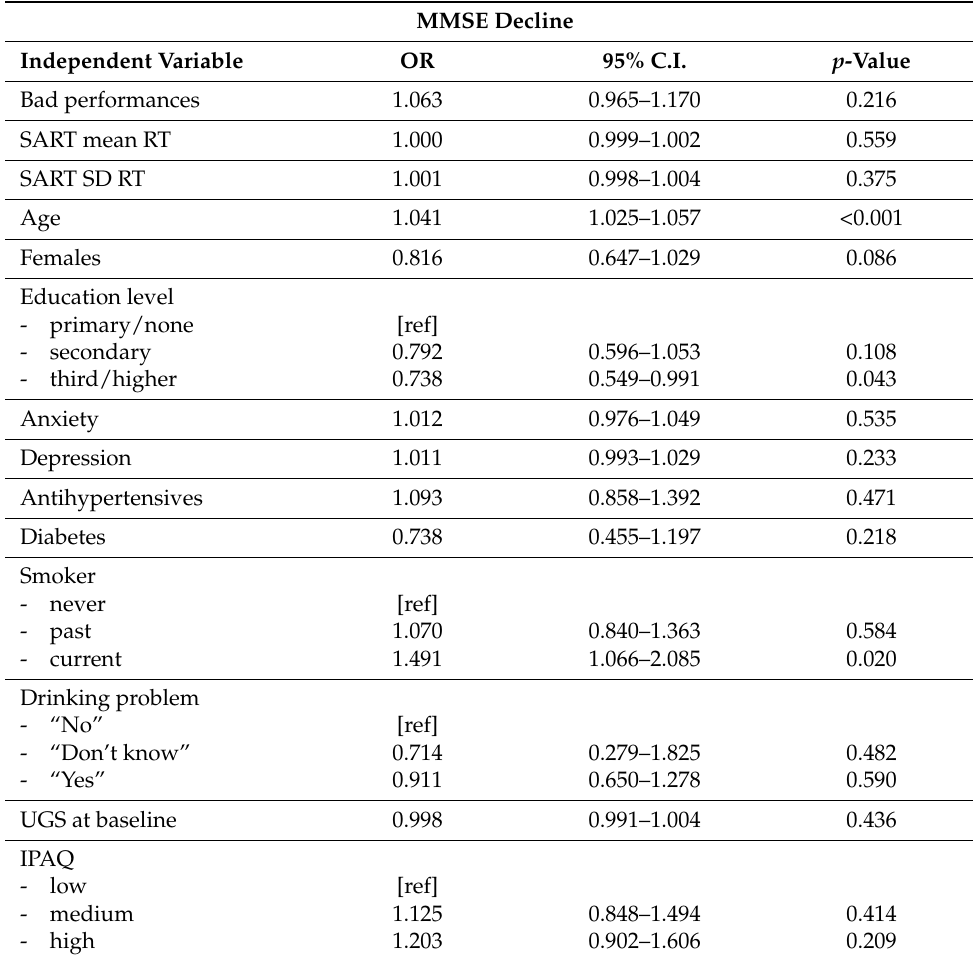
Table A8. Results for the fully adjusted per covariates binary logistic regression model 4a considering bad performances as potential predictor and having MMSE decline as